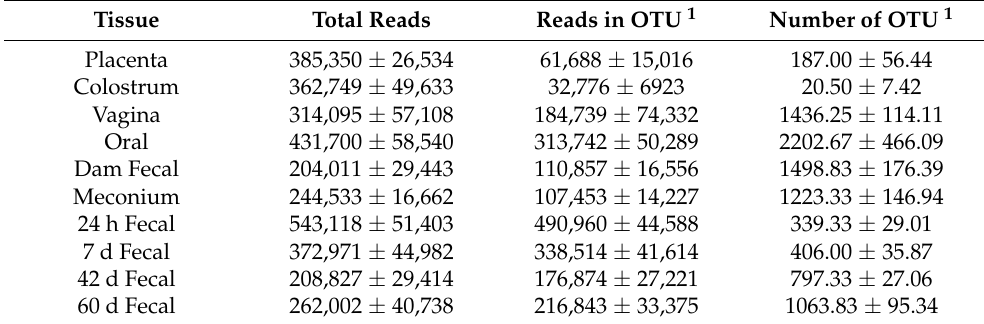
Table 2. Results from 300 bp paired end sequencing of V4 region of 16S rDNA amplicons on the Illumina MiSeq platform. Results are separated based on type of